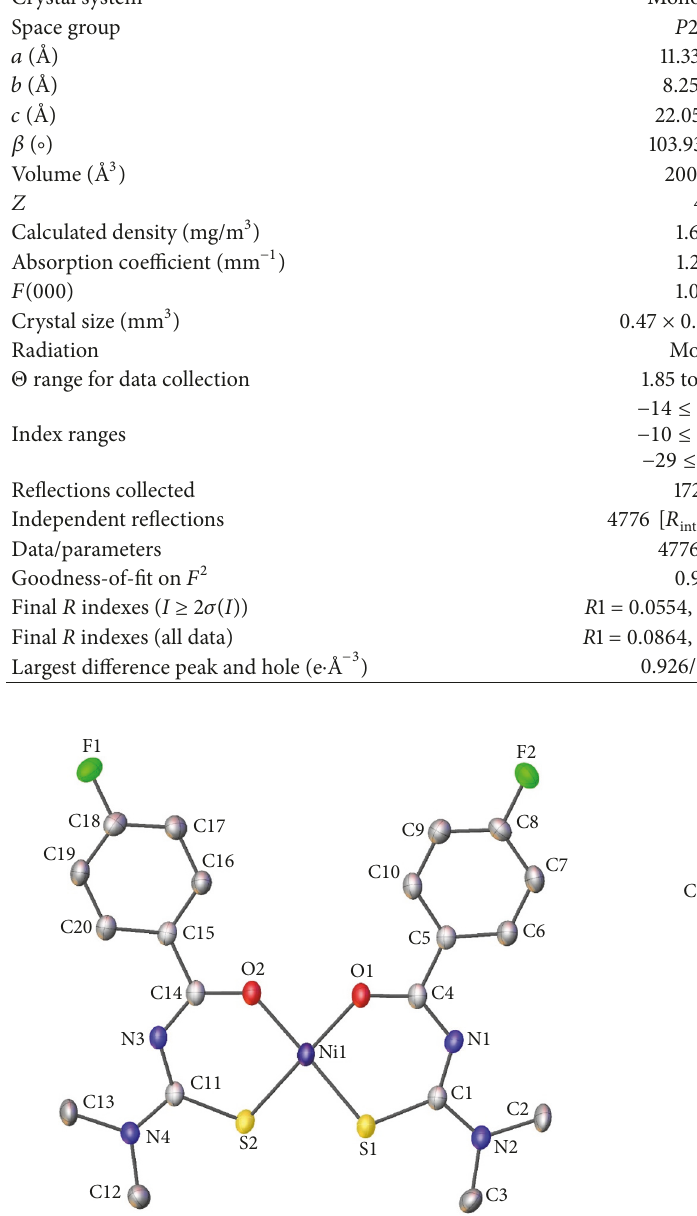
Figure 5: Molecular structure of CuL 2 with anisotropic displace- ment ellipsoids drawn at 50% probability level. H-atoms omitted for